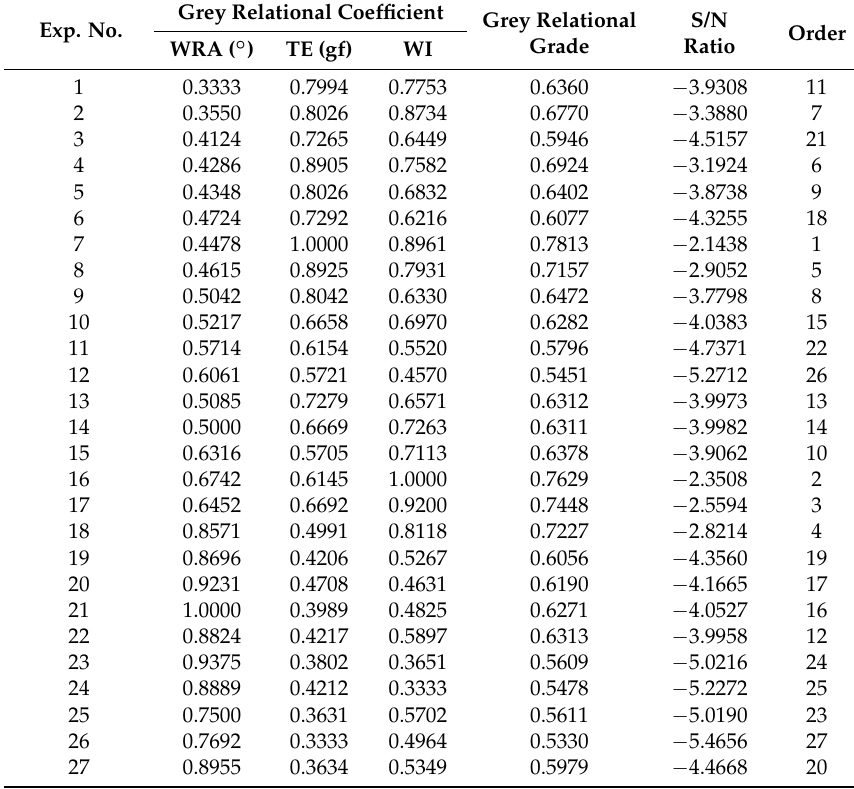
Table 11. The calculated grey relational coefficients and GRGs.